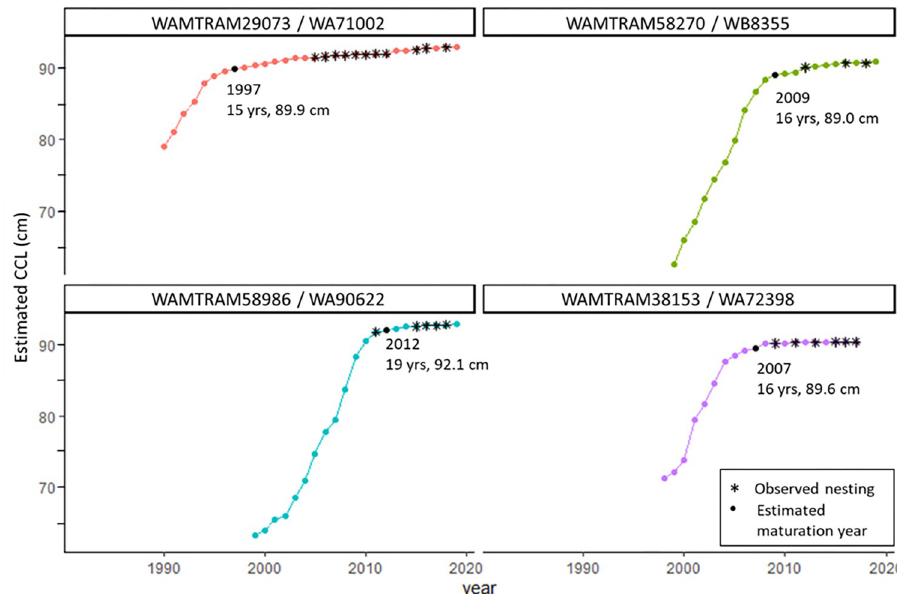
Fig 6. Flatbacks with nesting histories. The skeletochronology-assigned year and curved carapace length (CCL, cm) are shown for four analyzed humeri that were recovered from adult female flatback turtles with previous nesting histories observed during on-going nesting beach monitoring in Western Australia. Filled black circles show the skeletochronology-assigned maturation year for each turtle, with corresponding year, age (years) and CCL (cm) shown. Black asterisks show the year for each observed nesting event for each